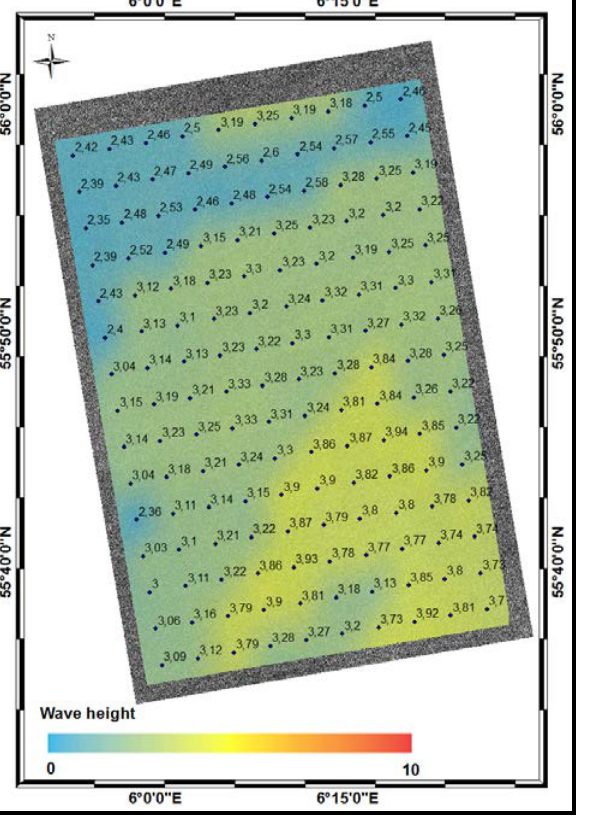
Figure 6. TerraSAR-X wave product